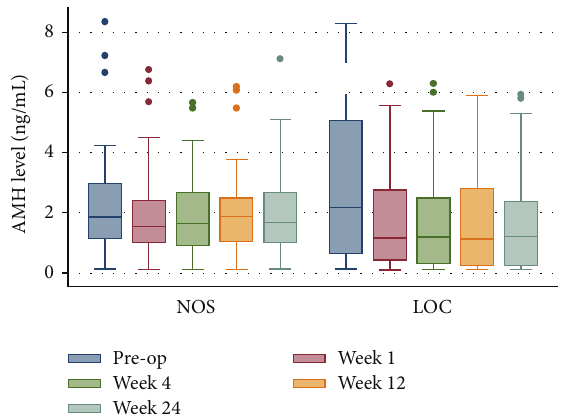
Figure 1: The correlation of serum AMH and age in participants. (AMH: antimullerian hormone). Figure 2: The changes in the serum AMH level at preoperative,